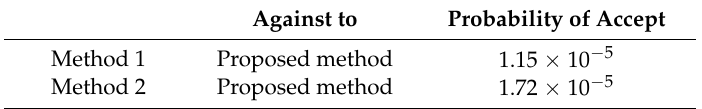
Figure 6. The comparison of accuracies among the three network structures. For each method, we repeated the simulation for each network structure 10 times. The bar is the mean of the accuracy of each method for 10 times. The error is the standard deviation of the accuracy of each method for the experiments repeated 10 times. Table 5. Wilcoxon rank sum test results of each method against the proposed method.